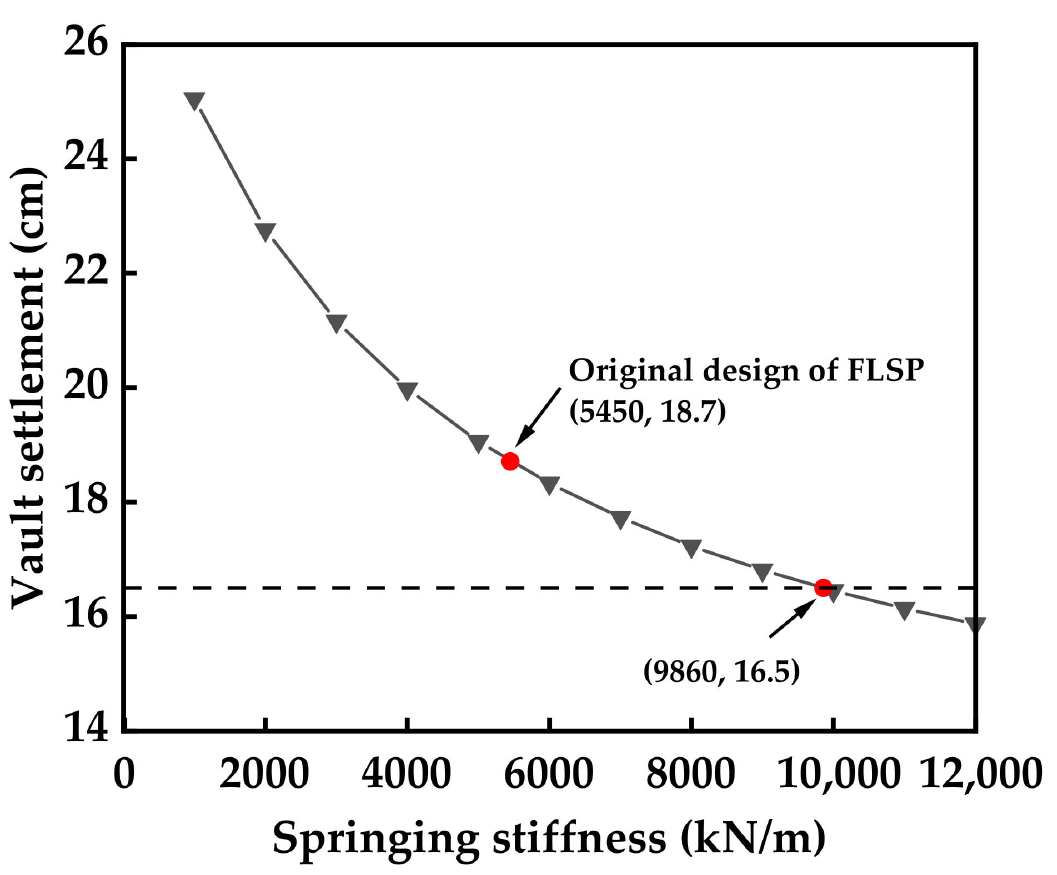
Figure 13. The relationship curve of vault settlement–spring stiffness. FLSPs with diameters of 42 mm, 50 mm, 89 mm and 108 mm, and wall thicknesses of 2 mm, 3 mm, 4 mm and 5 mm were taken as examples for selection. The reaction coefficient of the surrounding rock foundation was 150 MPa/m. The corresponding lateral stiffness was obtained from Formula (7) and the material parameter calculation, as shown